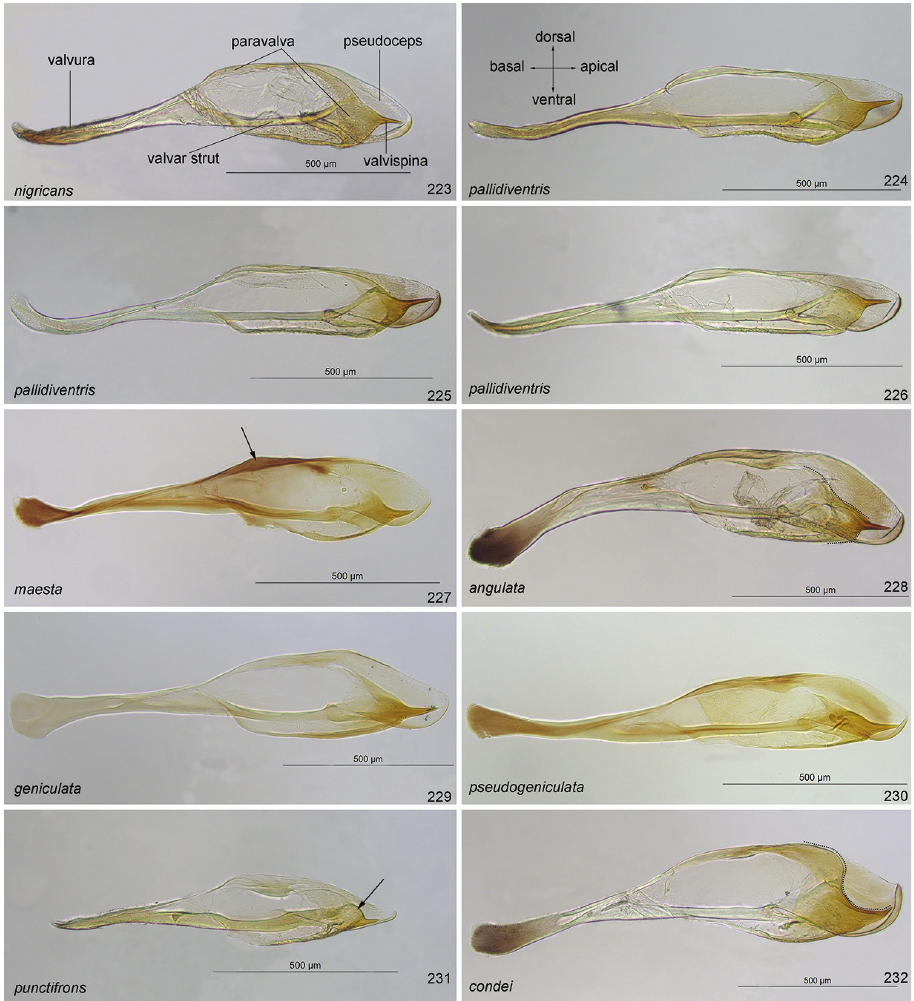
Figures 223–232. Penis valves of Pristiphora . 223 nigricans DEI-GISHym20869 224 pallidiventris DEI-GISHym20866 225 pallidiventris DEI-GISHym80143 226 pallidiventris DEI- GISHym20976 227 maesta PR.579VV (arrow indicates an angulate dark area) 228 angulata DEI-GISHym31030 229 geniculata PR.549VV 230 pseudogeniculata PR.577VV 231 punctifrons DEI-GISHym31669 (arrow indicates a round hump) 232 condei